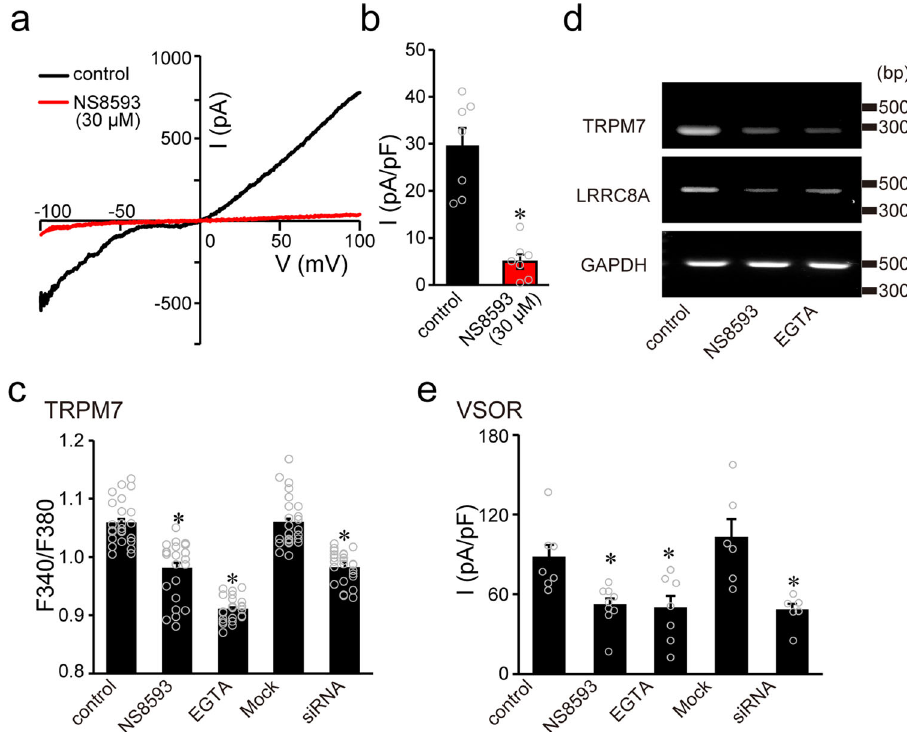
Fig. 2 TRPM7-mediated steady-state Ca 2 + in fl ux regulates the mRNA expression levels of TRPM7 and LRRC8A through the regulation of intracellular Ca 2 + concentration in HeLa cells. a Representative I – V relationships of currents in response to ramp pulses (50 ms duration) from − 100 to + 100 mV before ( control ) and after 2-day treatment with 30 µ M NS8593 ( NS8593 ). b Mean peak current densities at + 100 mV in the absence (black column) and presence of NS8593 (red column) ( n = 6). * indicates a P ( = 0.000058) value of <0.0001 compared to the corresponding control (left column) by t -test. c Cytosolic Ca 2 + levels were determined by fura-2 ratio imaging in the cells before ( control ) and after treatment with 30 µ M NS8593 for 2 days ( NS8593 ), 2 mM EGTA for 2 days ( EGTA ), mock siRNA for 2 – 3 days ( Mock ), and TRPM7-siRNA for 2 – 3 days ( siRNA ) ( n = 24). * P ( =